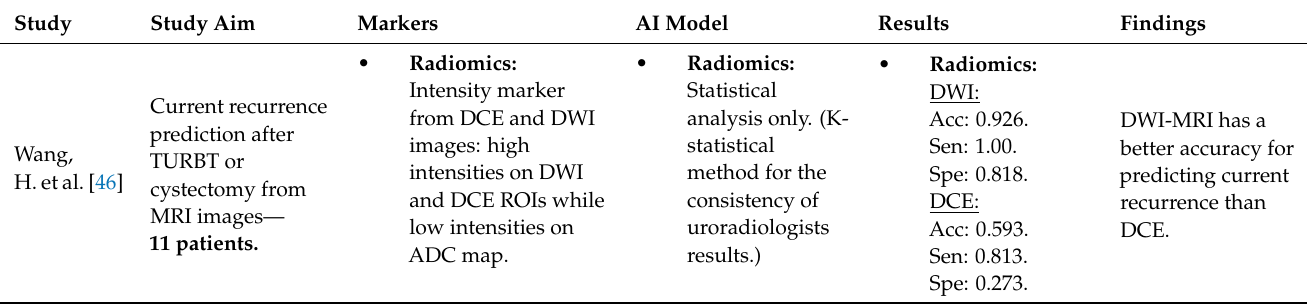
Table 1. Literature review on the use of radiomic markers to predict recurrence in